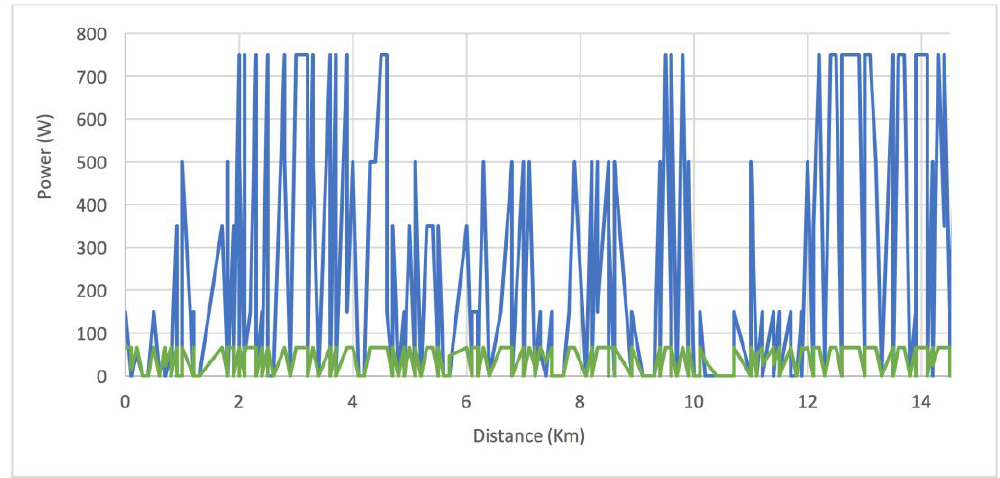
Figure 9. Power apportioned to each of the segments of the analyzed route. The power provided by the user (in blue) and the power provided by the electric engine (in green).